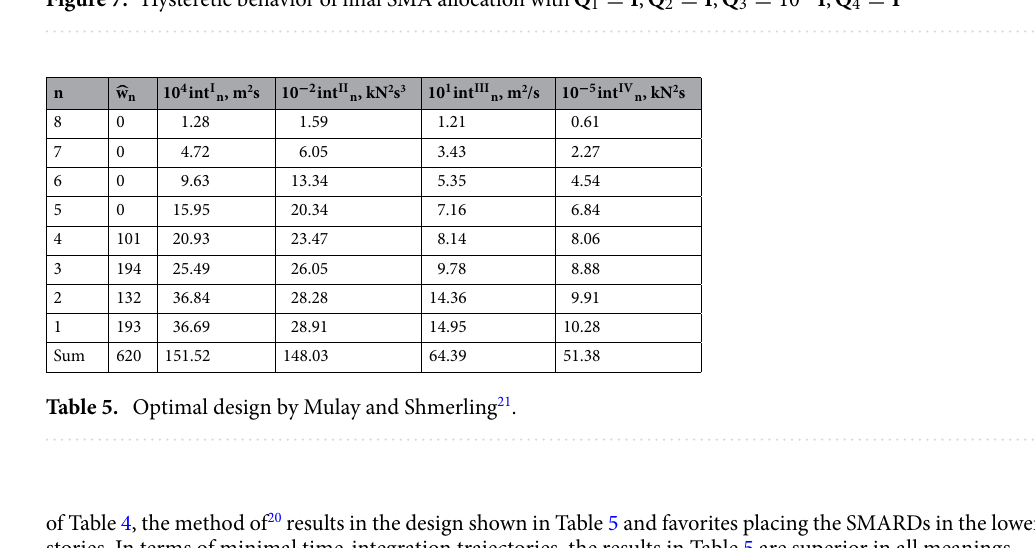
Figure 7. Hysteretic behavior of final SMA allocation with Q 1 = I , Q 2 = I , Q 3 = 10